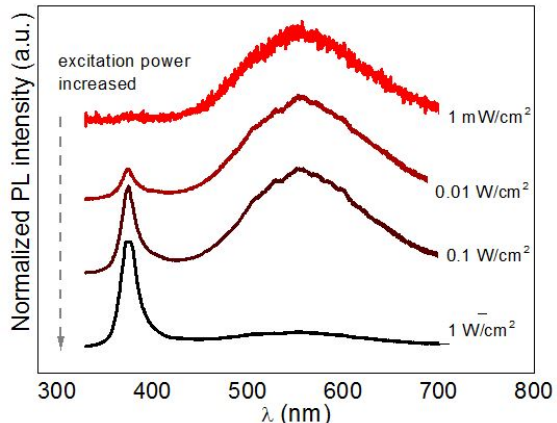
Figure 12. Evolution of the representative room-temperature PL spectra of ZnO NCs in solution as a function of the laser excitation power ( λ exc = 325 nm).